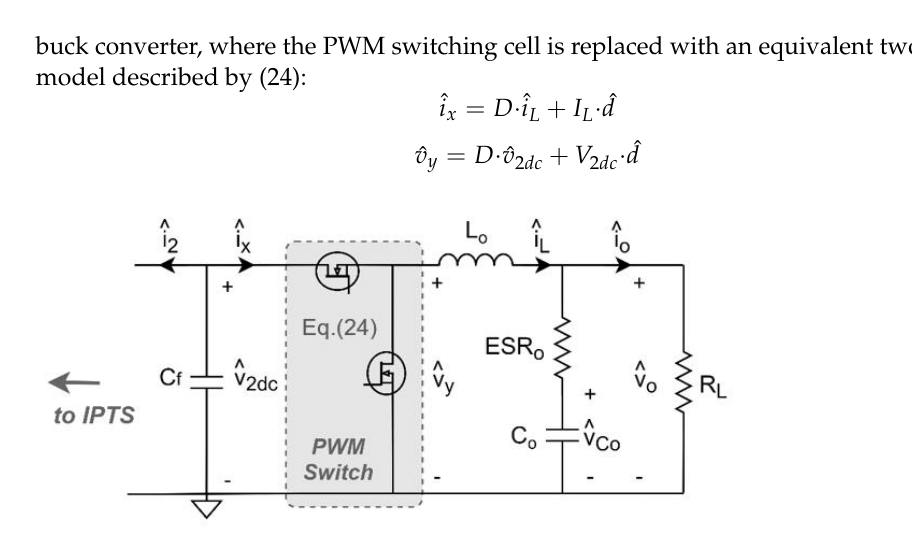
Figure 16. Averaged small-signal equivalent circuit of the buck converter. The “ˆ” operator in (24) denotes the small-signal variations of the considered quantities (note that the duty-cycle variation ˆ d is different from the normalized phase-shift d used